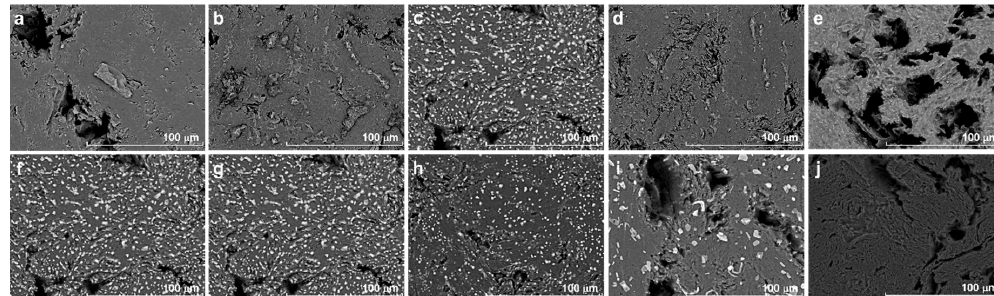
Figure 2. SEM images obtained for poly(4-HPA) films electropolymerized over graphite electrodes after ( a ) 25, ( b ) 50, ( c ) 100, ( d ) 150, and ( e ) 200 cycles of potential at 50 mV/s. The micrographs from f–i show the polymer films obtained with 100 cycles with different scan rates: ( f ) 25, ( g ) 50, ( h ) 75, and ( i ) 100 mV/s. The bare graphite electrode is also shown ( j ). Magnification of ×1000.